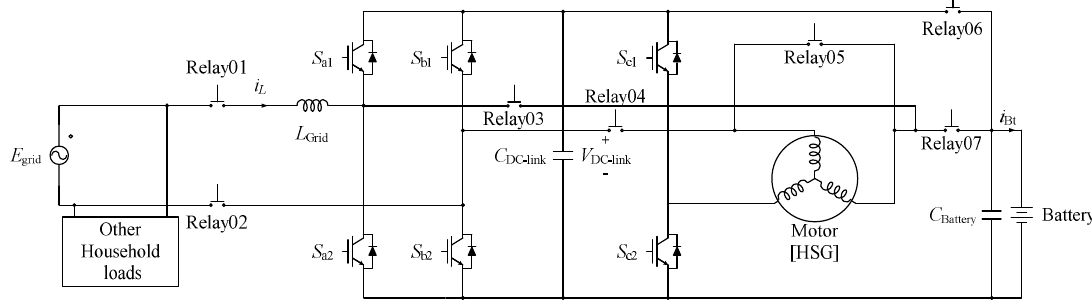
Figure 1. Proposed circuit for hybrid starter generator (HSG) driving and single-phase bidirectional on-board charger (OBC).